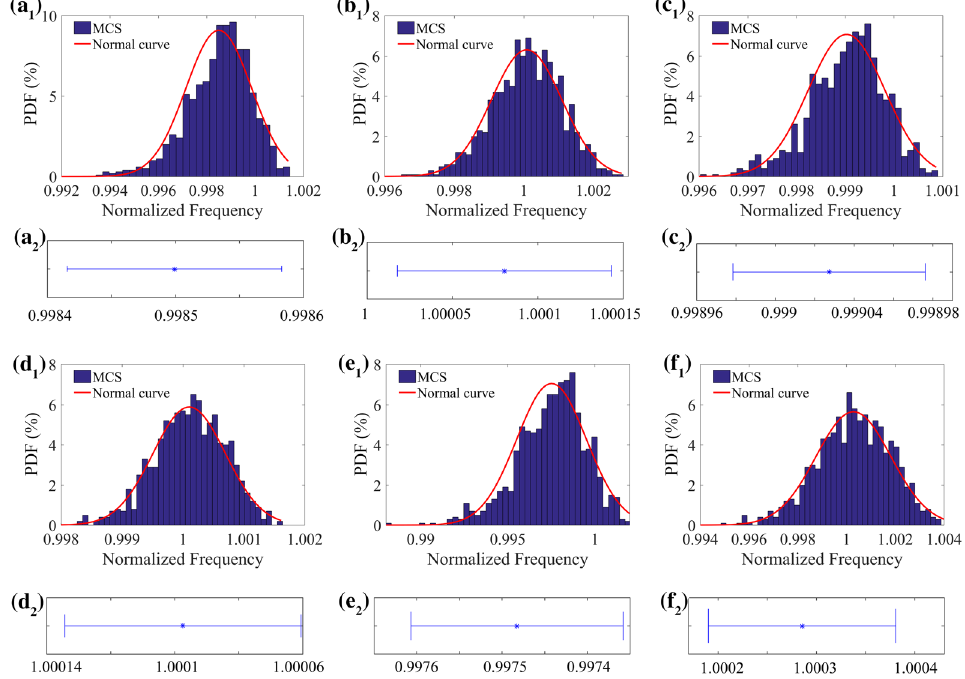
Figure 8 Probability density and the 95% confidence interval and mean of the first six frequencies for1000 random samples about mistuned restraint stiffness with σ k 20%: a The first order; b the second order; c the third order; d the fourth order; e the fifth order; f the sixth order = (subscript 1 represents the probability density, subscript 2 represents the 95% confidence interval and